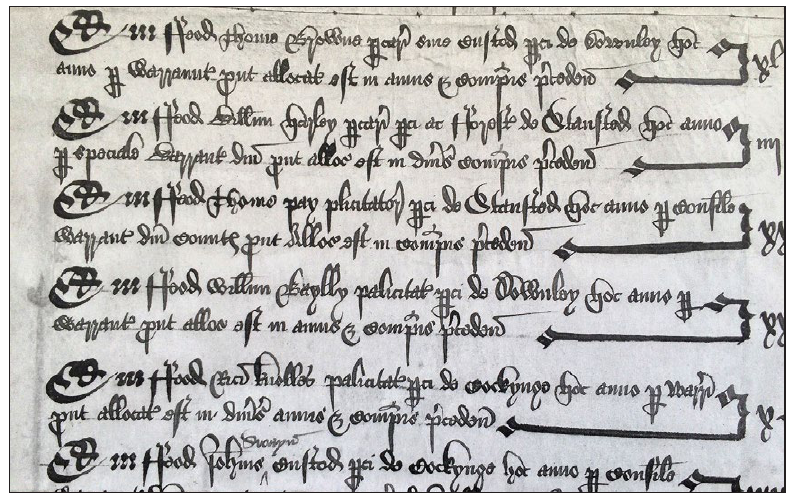
Figure 13: Compotus for the Honour of Arundel compiled for Thomas earl of Arundel in the early Sixteenth Century. Note the mention of William Baylly fencer in the park of Downley and at the top Thomas Browne who was the warden of the park. Photo: MBR (used with permission of His Grace the Duke of